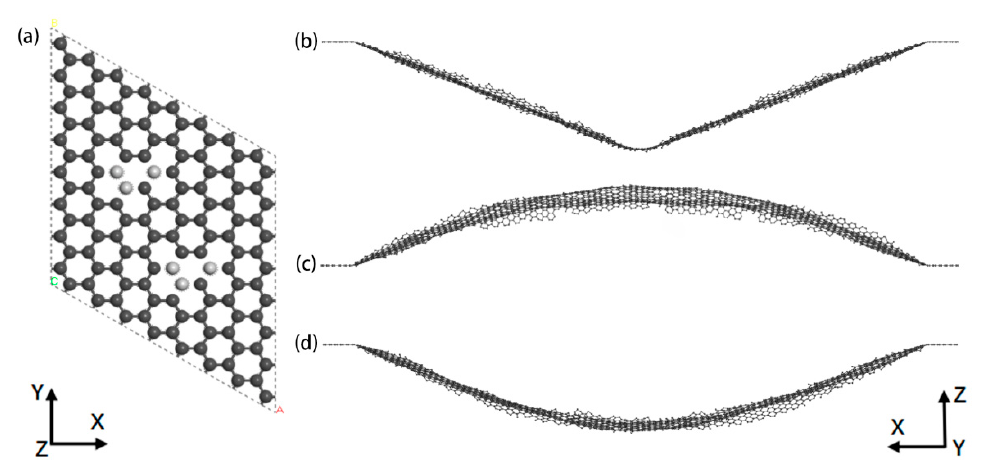
Figure 2. Graphene nanoribbons ( a ) Graphene supercell containing vacant 6(3 + 3) sites; ( b ) Initial bending state; ( c , d ) are vibration states at a certain time.